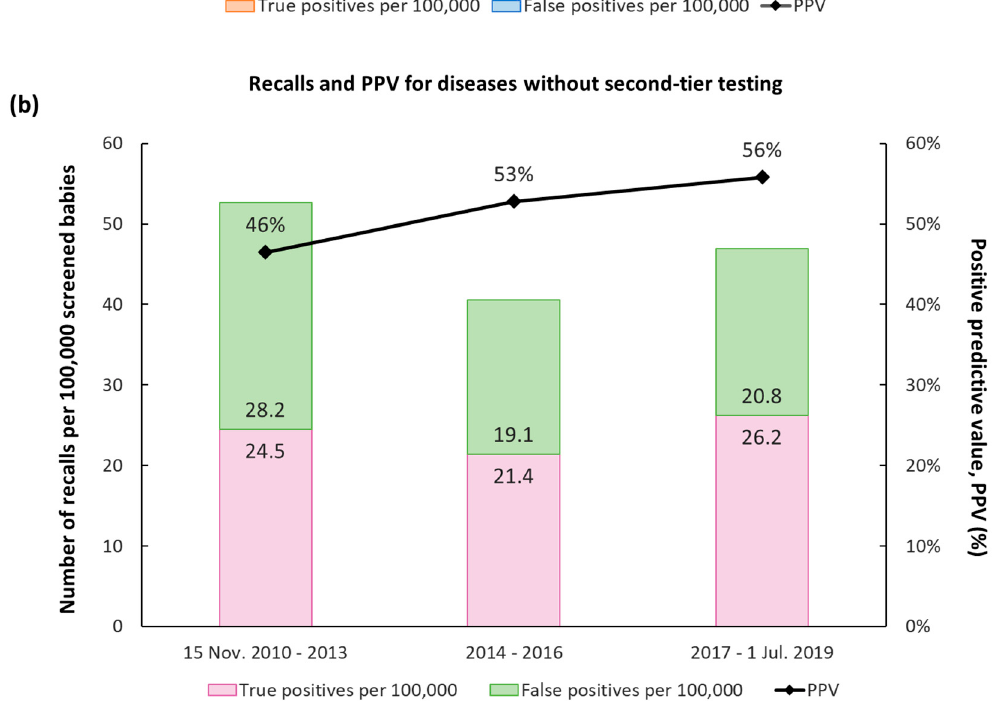
Figure 2. Recalls divided into three periods representing three different phases of the expanded screening program. Phase 1: 15 November 2010–2013; Introducing second-tier analysis for IVA; Using Singe Condition Tool in R4S; 351,211 babies screened. Phase 2: 2014–2016; Introducing Tool Runner and Dual Scatter Plot in R4S; 355,332 babies screened. Phase 3: 2017–1 July 2019; Introducing second-tier analyses for HCY, MMA, PA; Start using CLIR; 293,791 babies screened. During the whole period 1,000,334 newborns were thus screened, and the overall positive predictive value was 47%. ( a ) All recalls; ( b ) Recalls for all diseases except those where a second-tier analysis was implemented, i.e., all but MMA, PA, HCY, and IVA.